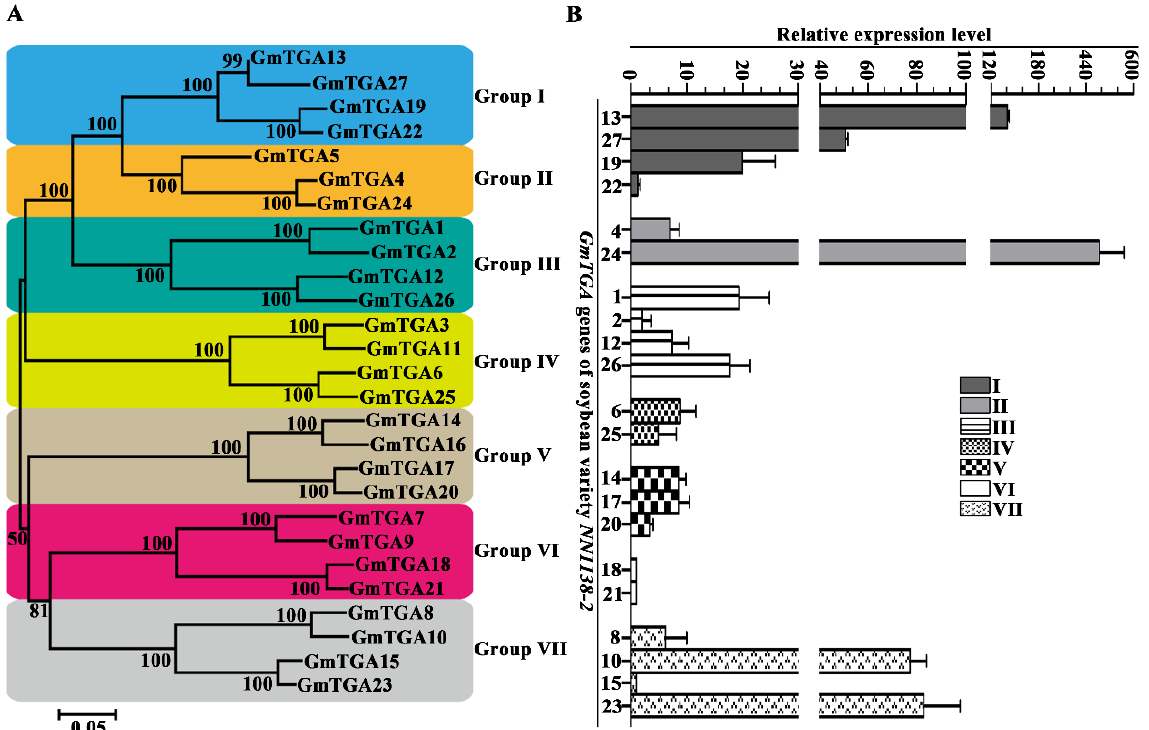
Figure 1. Phylogenetic relationship analysis of 27 GmTGA proteins of soybean NN1138-2 and expression profile of these GmTGA genes in the unifoliate leaves. ( A ) Phylogenetic relationship analysis of 27 GmTGA proteins. The amino acid sequences of 27 GmTGA proteins from soybean NN1138-2 were used to construct the neighbor-joining (NJ) tree using MEGA 6.0 with 1000 bootstrap replicates, from which 7 groups of GmTGA were identified. ( B ) Expression profile of GmTGA genes in fully developed unifoliate leaves tissue. The mRNA transcript levels of 27 GmTGA genes were analyzed using qRT-PCR in the unifoliate leaves. Out of them, the fluorescence signal of 21 GmTGA genes were detected while others not. GmEF1B and GmActin11 were used as internal controls. All experiments were performed with three independent biological repeats. The error bars represent the standard deviation.